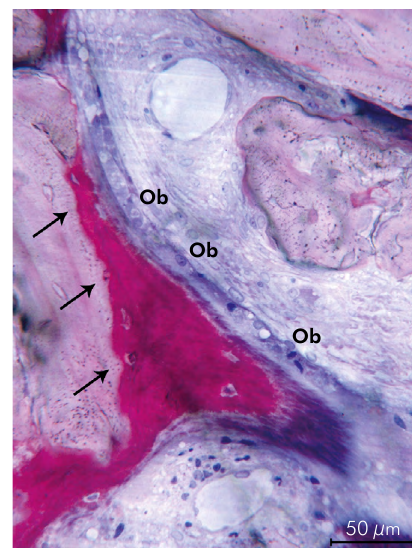
Figure 5. Group 2: in a marrow space a rim of osteoblasts (Ob) deposing new bone directly on the porcine bone granule surface was evident. The portion of the particle in contact with the young bone was intensely stained and showed irregular margins (arrows), so it might have previously undergone a